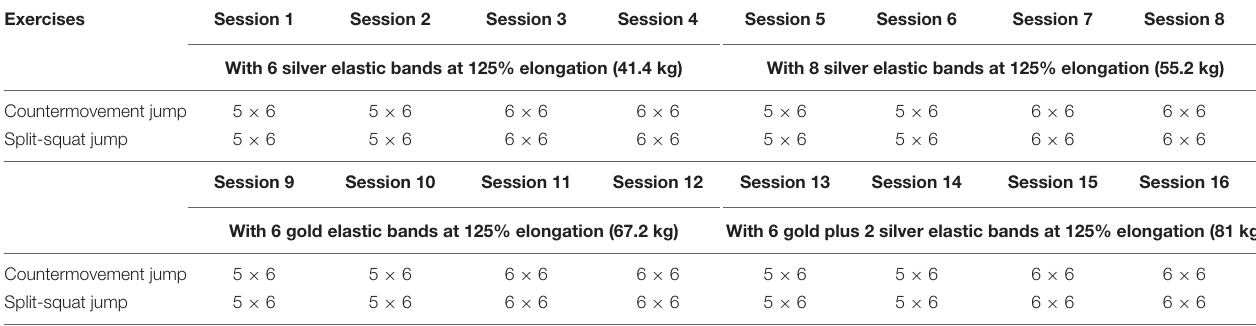
TABLE 2 | Details of elastic band-based plyometric training program performed by the experimental group over the 8 week intervention.